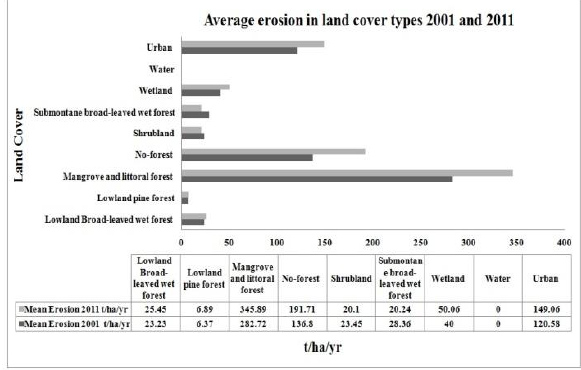
Figure 7. Average erosion in land cover types in 2001 and 2011 Figure 5. Rio Grande watershed soil erosion estimates for 2001 and 2011